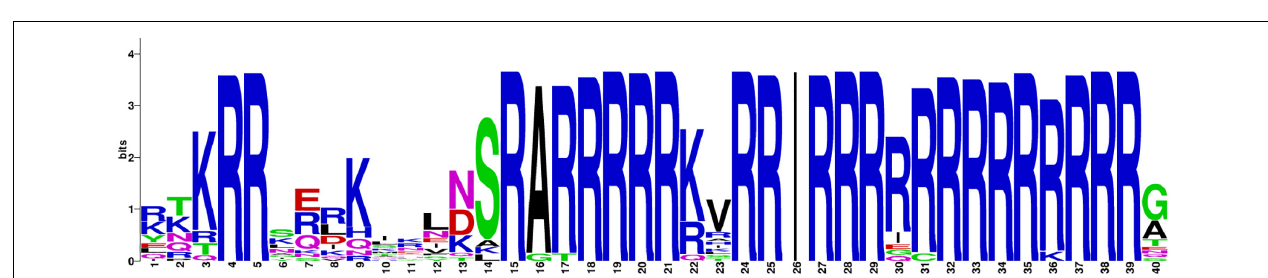
FIGURE 2 | The amino acid sequence alignment for seven chloroplast genes of Trentepohliales and other representatives of Chlorophyta. Positions corresponding to UGA/UAG codons in Trentepohliales are indicated by an asterisk. The vertical blank space between alignment matrix represents regions of the sequence alignment that were omitted for simplicity. For each gene, position in the alignment is indicated by the numbers shown above the sequence.